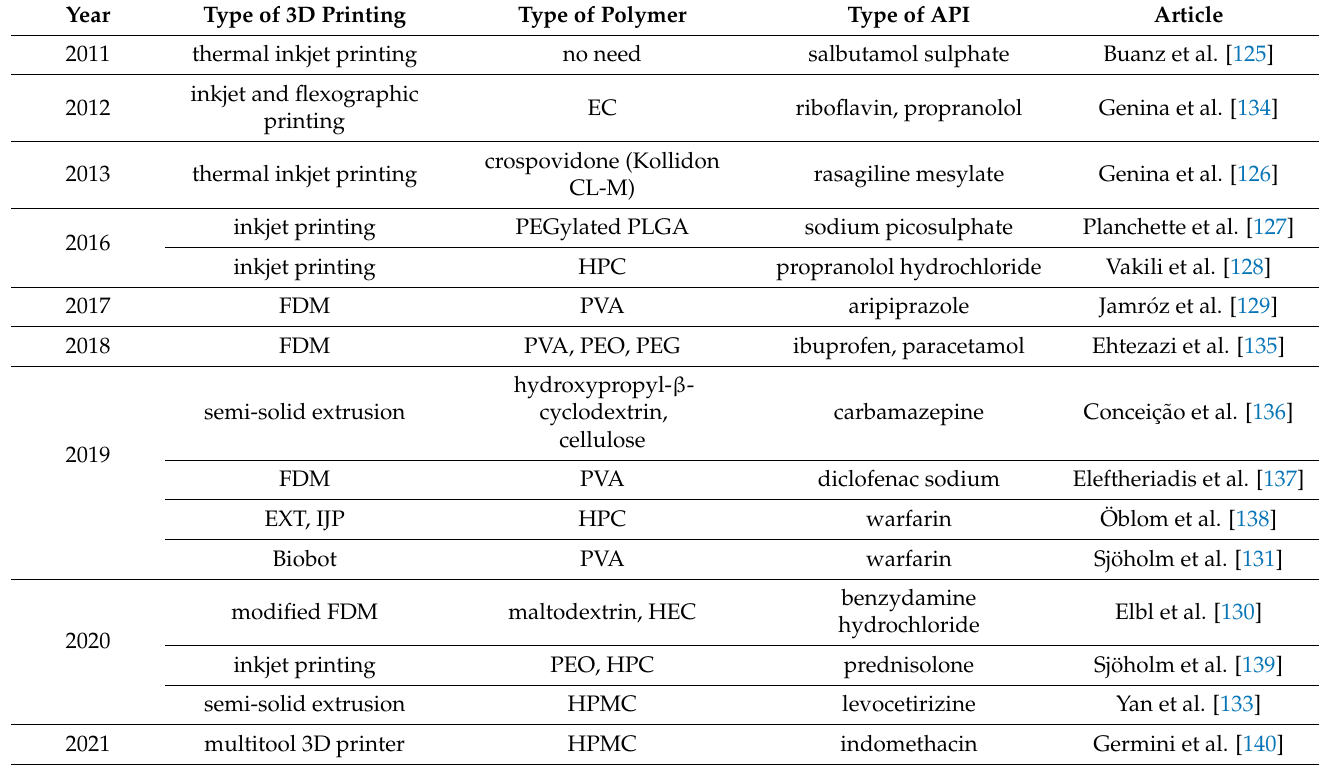
Table 4. The grouping of the manufactured orodispersible films based on the publication year and then in alphabetical